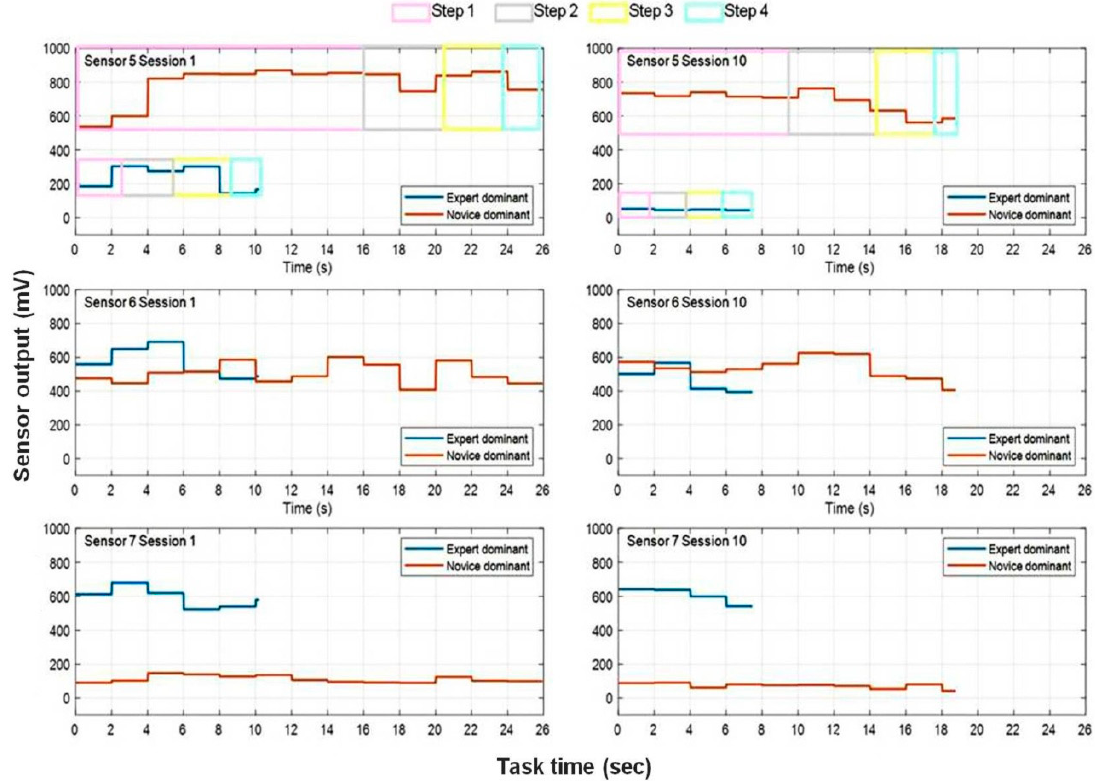
Figure 10. Individual grip-force profiles showing average peak amplitudes (mV) from sensors 5, 6, and 7 for fixed successive temporal windows of 2000 milliseconds in a given session, for the first and last of ten sessions of the expert and the novice. Relative durations of each of the four critical task steps within a given session are highlighted by the colored boxes corresponding to those shown in Table 2 on the example of sensor 5 (top left and top right).